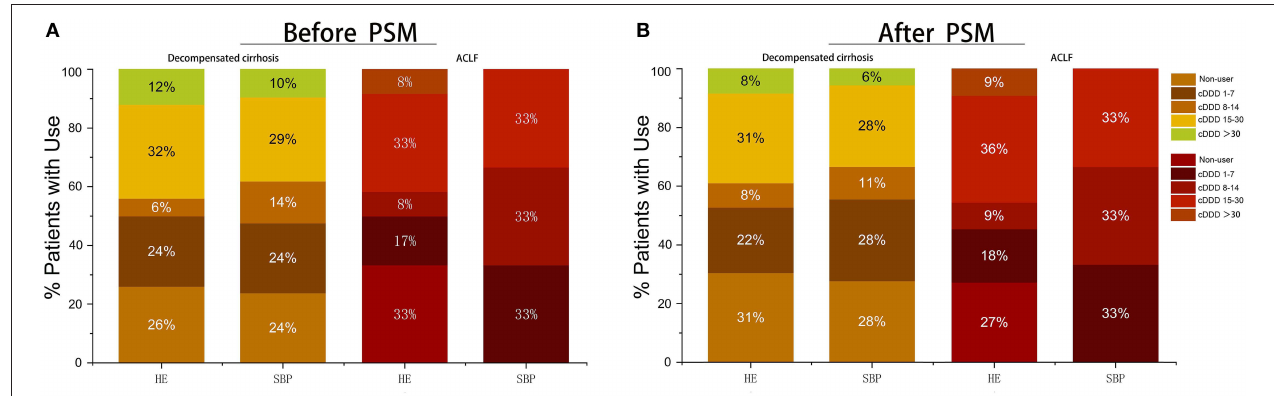
FIGURE 3 | Proportion of patients with different doses and without PPI treatment who suffer from complications during hospitalization. (A) Proportion of patients with different doses and without PPI treatment before PSM; (B) Proportion of patients with different doses and without PPI treatment after PSM. cDDD, cumulative defined daily dose; PPI, proton pump inhibitor; ACLF, acute-on-chronic liver failure.